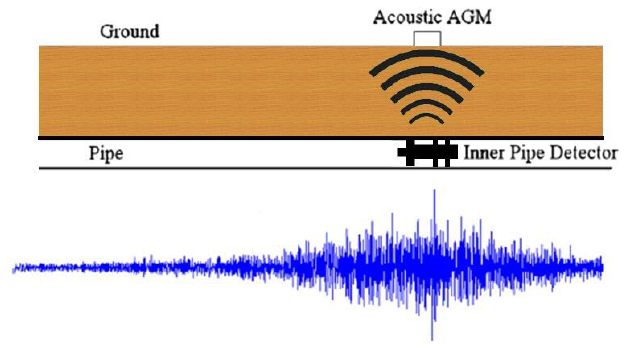
Figure 12. Signal acquired by an acoustic AGM when an inner pipe detector is approaching.